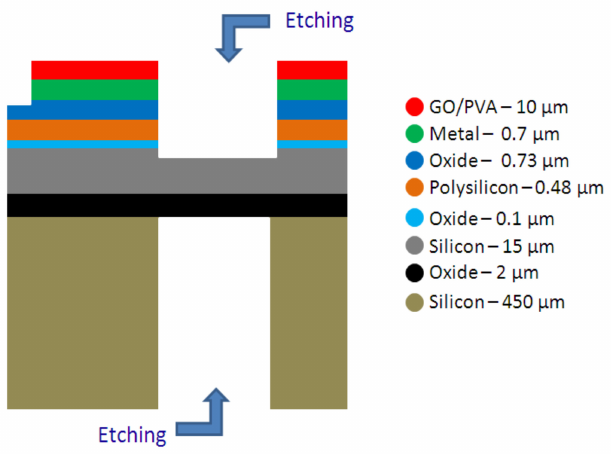
Figure 3. Fabrication process (bulk and etch silicon-on-insulator; BESOI) for the realization of the microsensor (not to